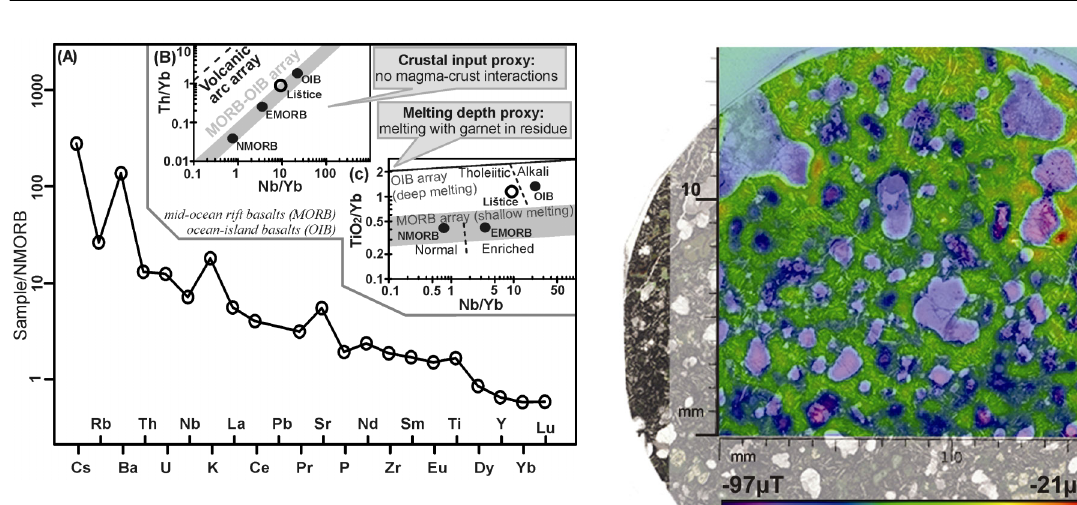
Fig. 4. Trace-element composition of Li(cid:154)tice quarry basalt. ( A ) spiderplot normalized by average NMORB composition (Sun & McDonough 1989); ( B ) Th/Yb versus Nb/Yb plot and ( C ) TiO 2 /Yb versus Nb/Yb (after Pearce 2008).